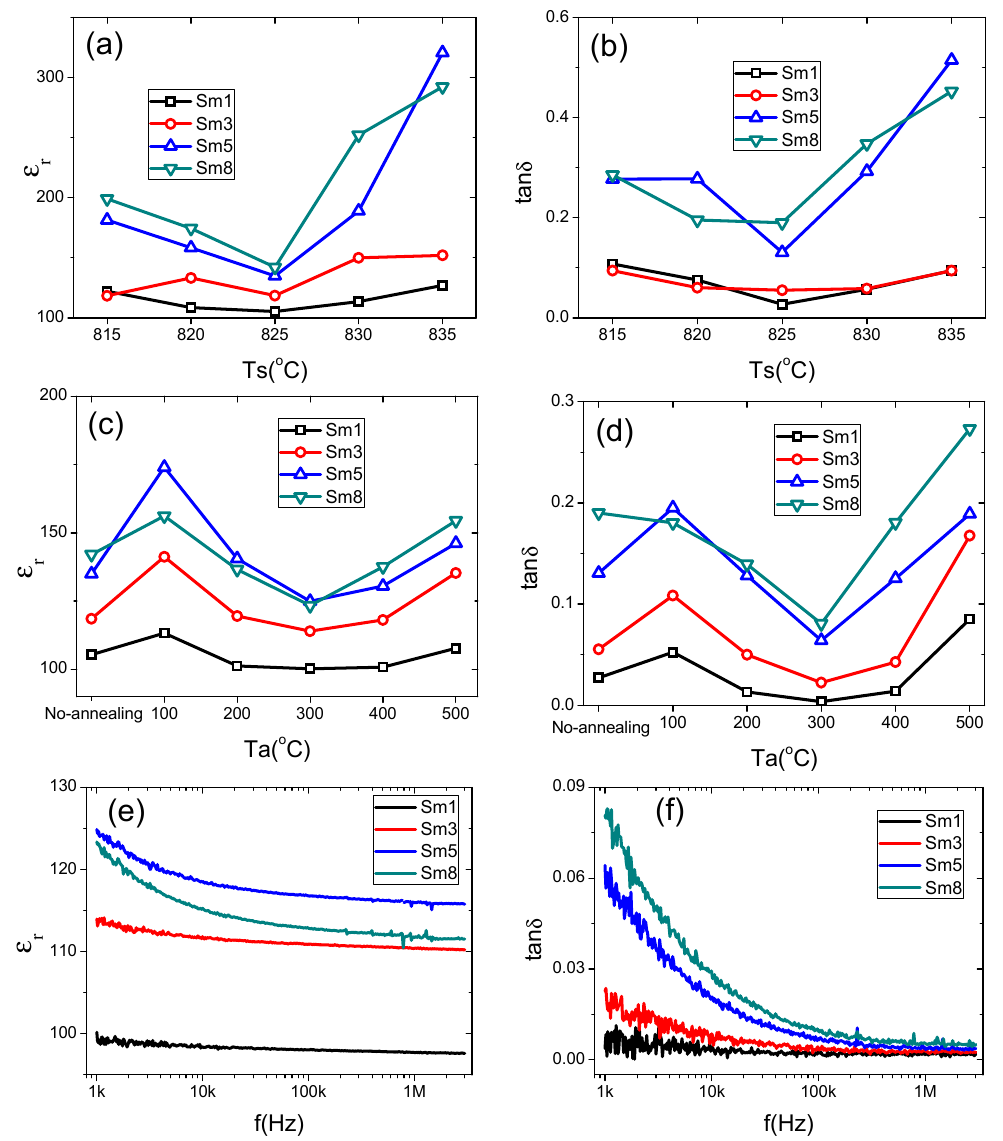
Figure 2. Sintering temperature (T s ) effects on the ( a ) relative dielectric constant ε r and ( b ) dielectric loss tan δ ; annealing temperature (T a ) effects on the ( c ) ε r and ( d ) tan δ of Sm-doped BFO ceramics. The results were measured at 1 kHz. ( e ) and ( f ) show the frequency ( f ) dependency of ε r and tan δ of the Sm-doped samples after sintering at 825 °C and annealing at 300 °C.